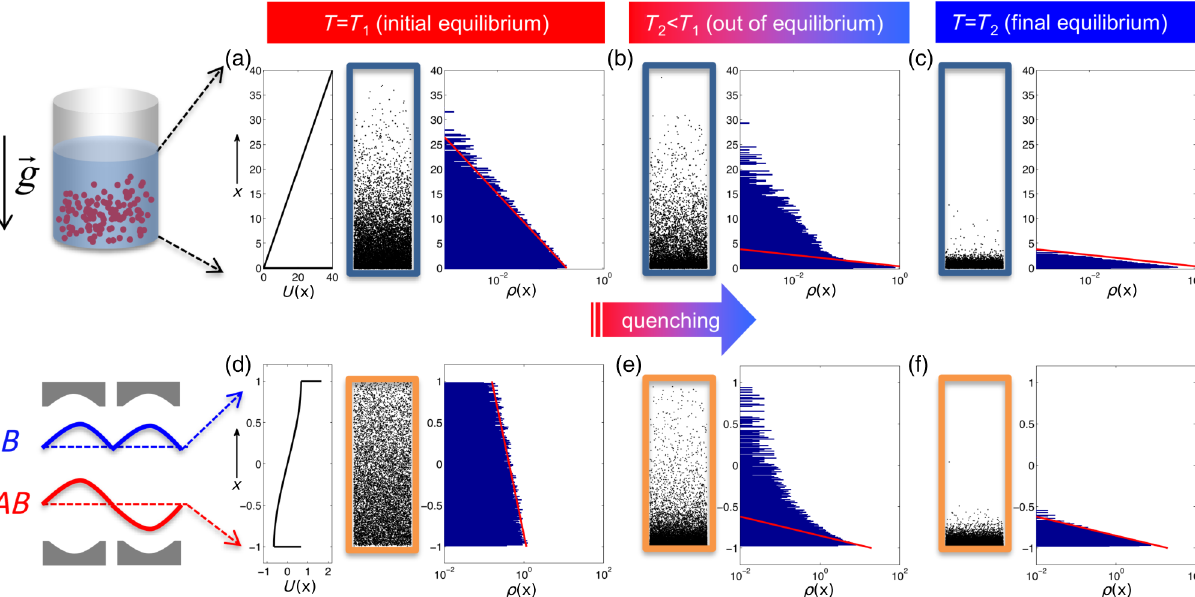
FIG. 4. Quenching analogy between a suspension of Brownian particles in a fluid (a) – (c) and a double cavity laser with mode energy flow from bonding ( B ) to antibonding ( AB ) modes (d) – (f). (a), (d): Initial equilibrium; from left to right: potential energy, a snapshot of the physical ensemble ( 10 4 particles), height histogram (blue bars), and the steady-state equilibrium distribution ρ Eq. (8)]. (b), (e): Quenched phase. The far nonequilibrium distributions are due to the abrupt decrease of the reservoir temperature from T 1 to T 2 < T 1 . Particles located at high altitudes remain “ hot, ” while lower particles cool down more rapidly. (c) – (f) Final equilibrium at T ¼ T 2